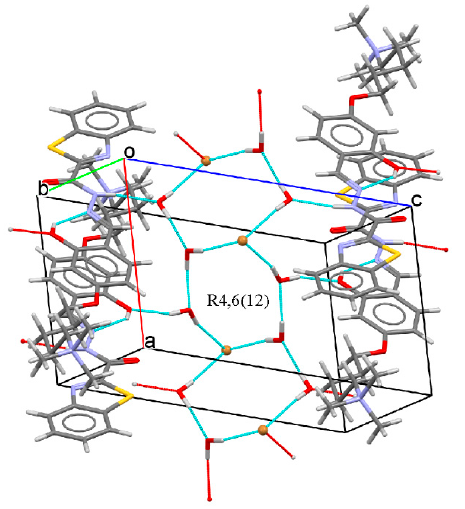
Figure 4. Partial packing showing the H-bonding pattern. Intra- and intermolecular hydrogen bonds are drawn as cyan dashed lines.